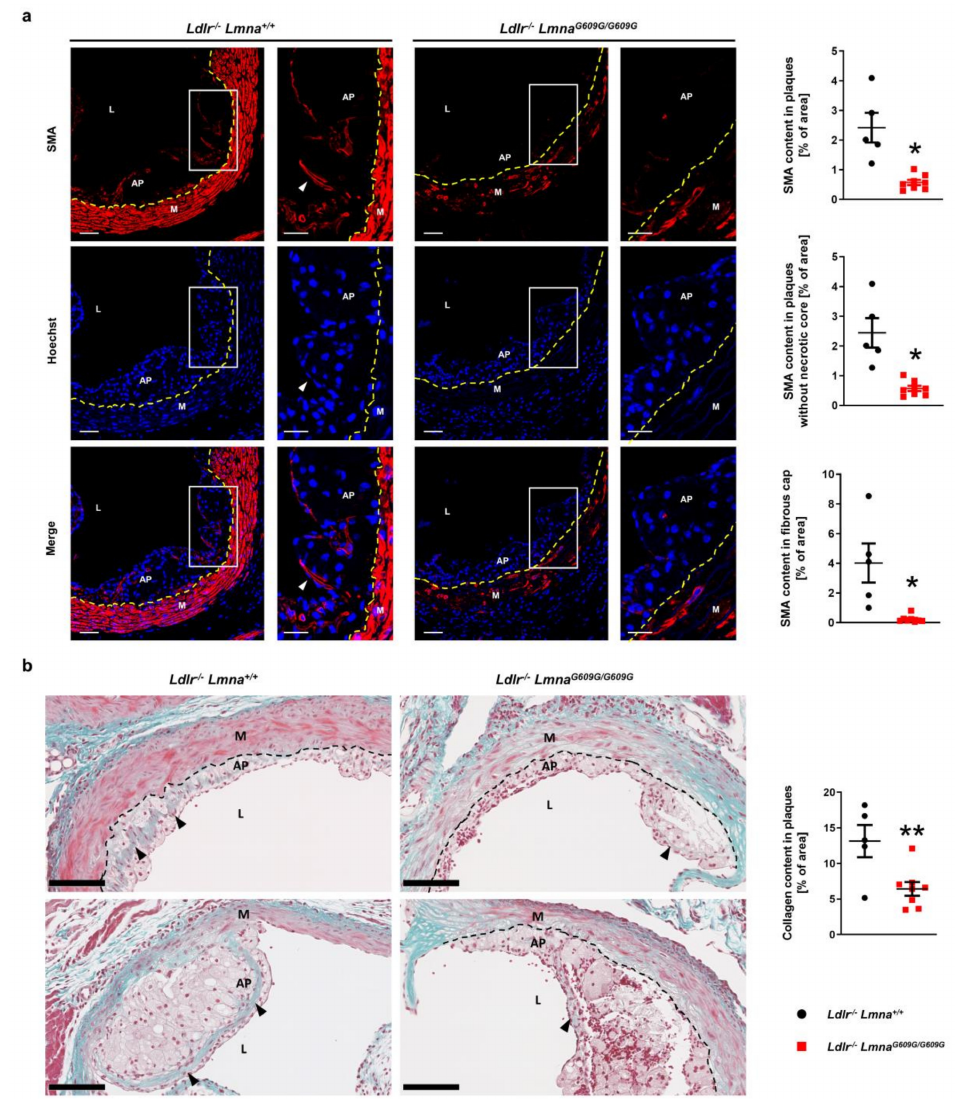
Figure 3. Lower smooth muscle cell and collagen content in atheromas of fat-fed male Ldlr − / − Lmna G609G / G609G mice. Male mice were fed a high-fat diet from eight weeks of age and